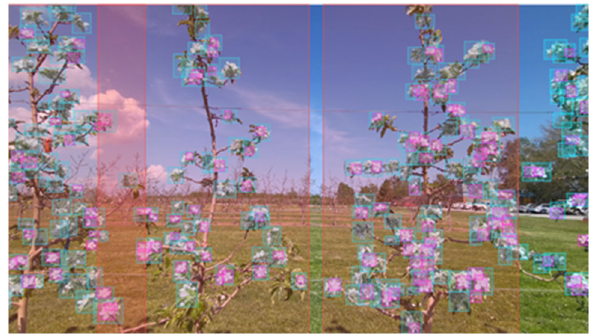
Figure 6. Training dataset with updated tree bounding box.